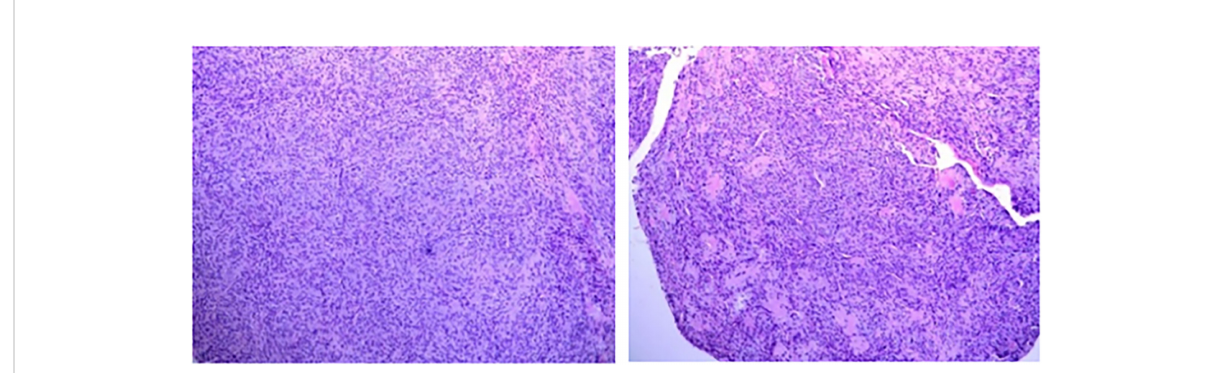
FIGURE 6 Microscopic examination of the thoracic spine metastatic tumor with HE staining (×100).